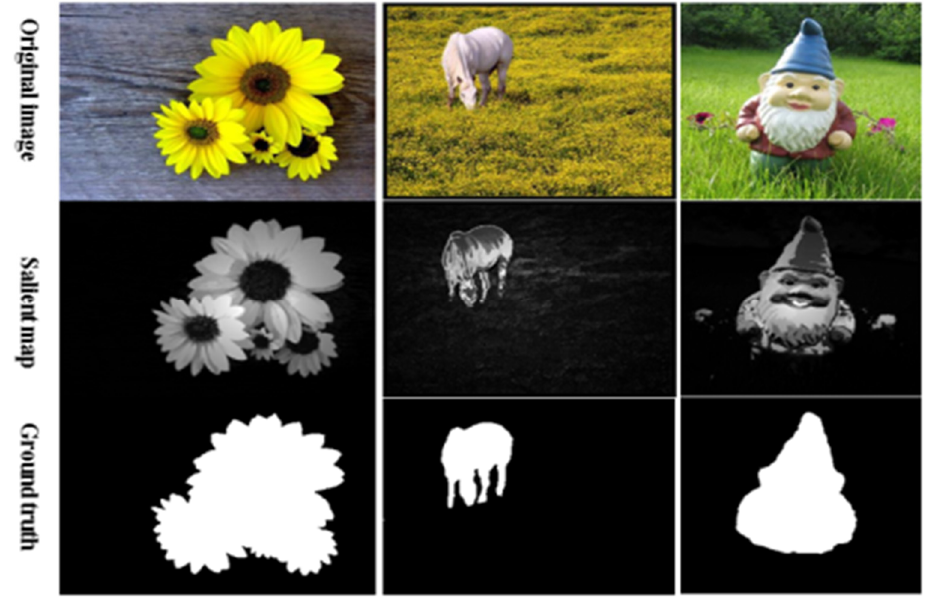
Figure 1. An example comparison of original images, salient maps and ground truth; from top to bottom: original images, salient maps and ground